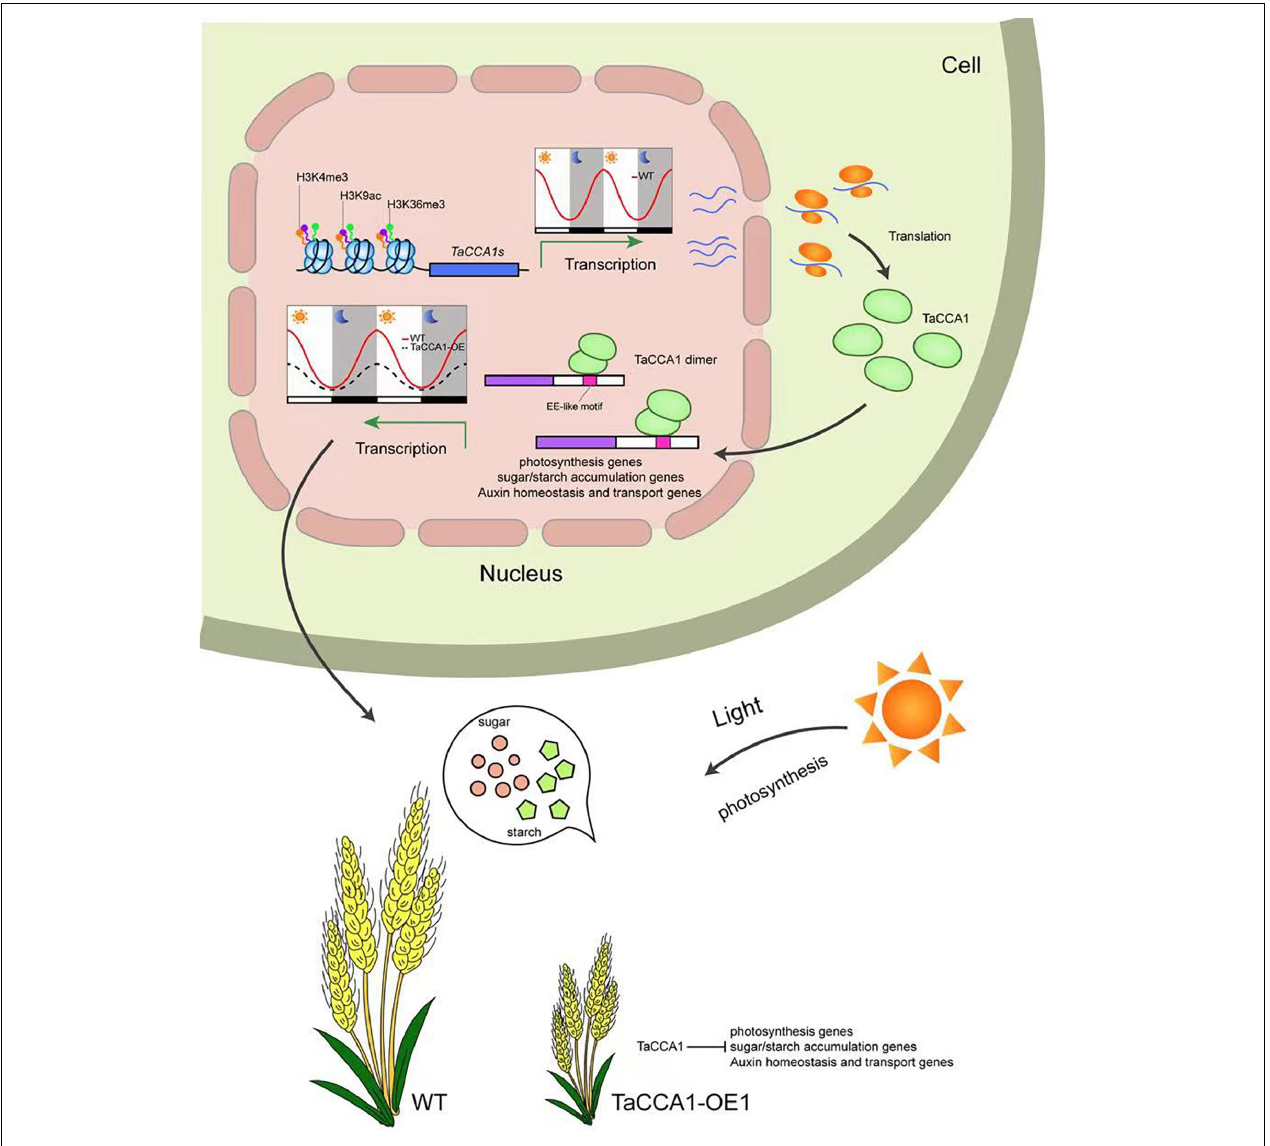
FIGURE 8 | Working model of possible molecular mechanism of the central circadian clock protein TaCCA1-mediated pathways involving in seedling growth and spike-related traits in wheat. TaCCA1 homoeologs exhibit typical diurnal expression patterns, which are positively regulated by rhythmic histone modifications. TaCCA1s are preferentially located in the nucleus and tend to form homo- or heterodimers. Overexpressing of TaCCA1 downregulates genes implicating in photosynthesis, energy metabolism, and auxin homeostasis through binding EE-like motifs, restricting the seedling growth and development of spike-related traits.